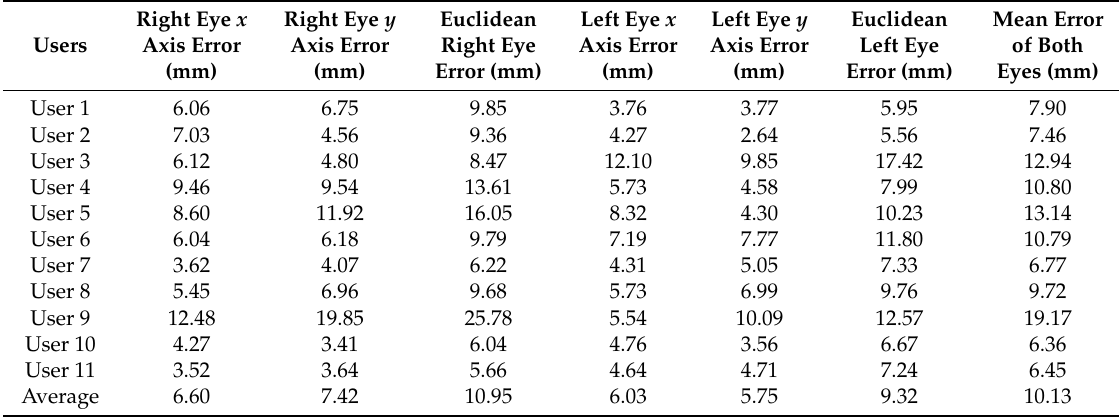
Table 3. Estimation results of gaze tracking accuracies in mm.